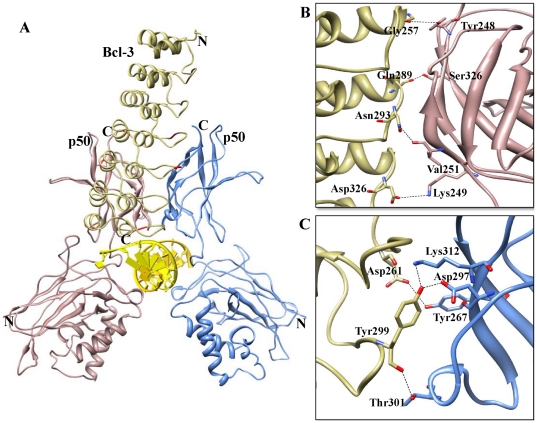
Complex B (Bcl-3 ARD-p50/p50 homodimer) interface.(A) The p50/p50 homodimer represented as a ribbon diagram are shown in rosy brown and blue, respectively. Docked Bcl-3 is represented in khaki color in the ribbon diagram, and flexible residues involved in the interactions are red colored. (B) The p50 (chain A)-Bcl-3 binding interface. Side chains of the amino acids contributing to hydrogen bonding formation (indicated by black dotted lines) are represented by a stick model with the residue names and numbers shown next to them. (C) The p50 (chain B)-Bcl-3 binding interface is also represented in a similar fashion as (B).